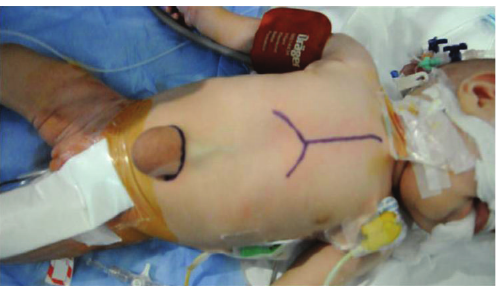
Figure 1: The patient while prepared for surgery. Pulsatile supraumbilical mass which was initially diagnosed as umbilical hernia.